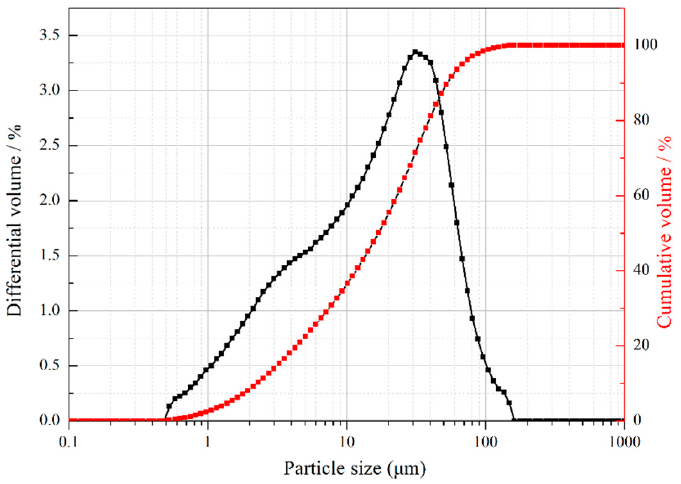
Figure 2. Particle size distribution of mussel shells powder.